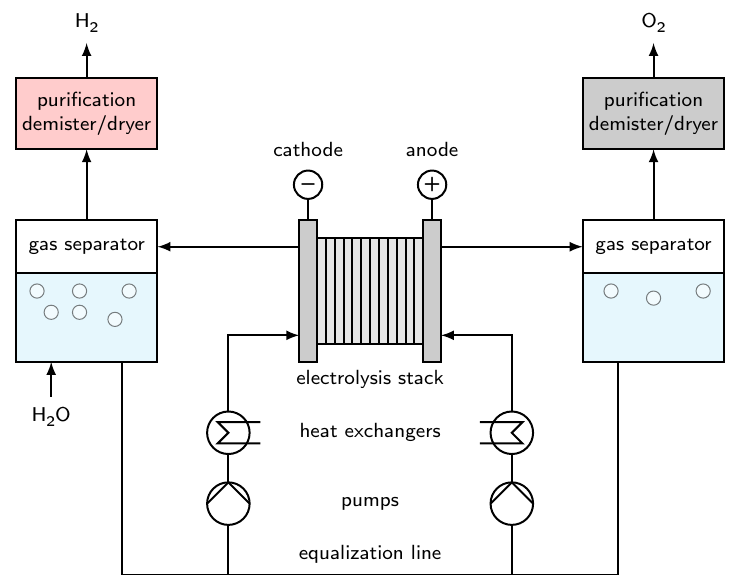
Figure 2. A schematic flow diagram of an alkaline water electrolyzer. The electrolyte is pumped through the electrolysis cell where the gas evolution takes place. Adjacent gas separators split both phases, and the liquid phase flows back to the electrolysis stack. Heat exchangers ensure that the optimal temperature is maintained, and the product gases can be purified